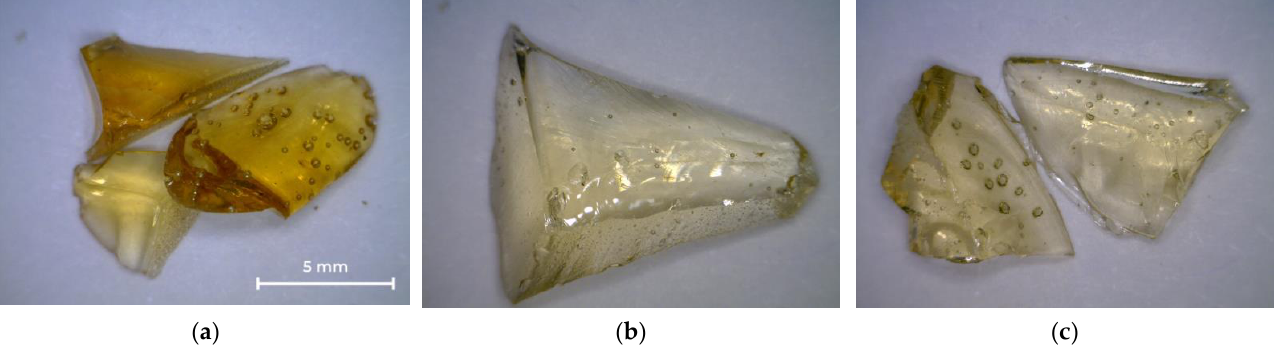
Figure 6. Photos of OEPT-1, ODEEPT-1, and OPEPT-1 samples: ( a ) OEPT-1; ( b ) ODEEPT-1; ( c ) OPEPT-1.